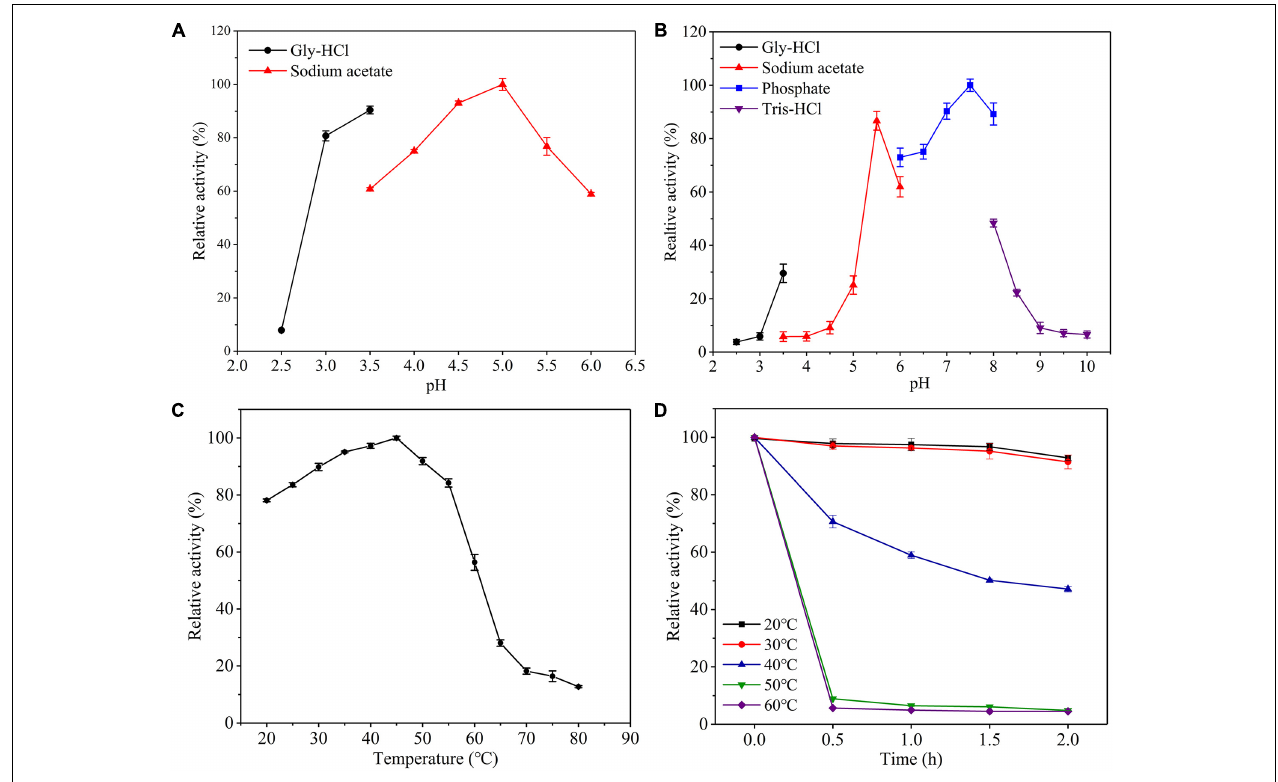
FIGURE 2 | Effect of pH and temperature on the activity and stability of the purified Csn-SH. (A,B) Optimal pH and pH stability. (C,D) Optimal temperature and thermostability. The initial catalytic activity without preincubation was used as control, which was defined as 100%.